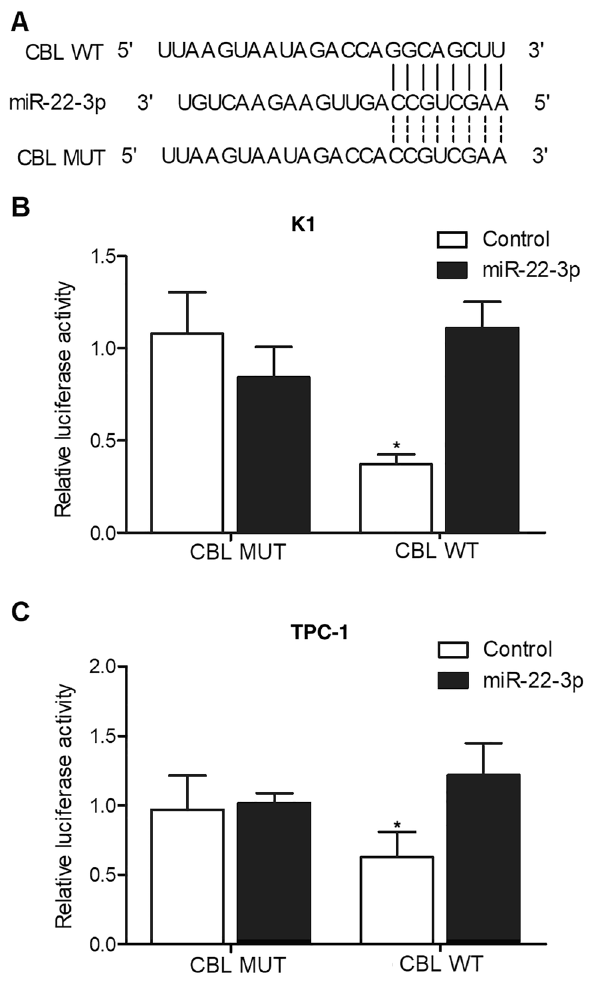
Figure 5. MiR-22-3p suppressed the expression of CBL through binding to its 3’ UTR (*P value < 0.05 vs. control). (A) Sequence analysis indicated binding of miR-22-3p to the 3’ UTR of CBL. (B) The luciferase activity of wild type CBL was inhibited by miR-22-3p in K1 cells. (C) The luciferase activity of wild type CBL was inhibited by miR-22-3p in TPC-1